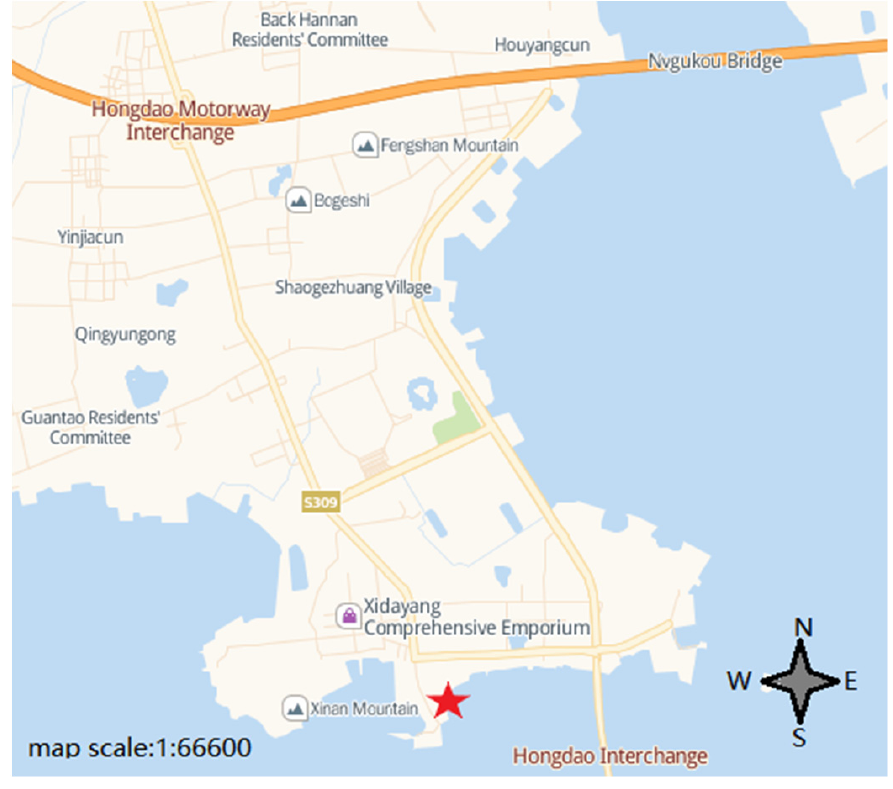
Figure 2. The test site and its surrounding terrain.